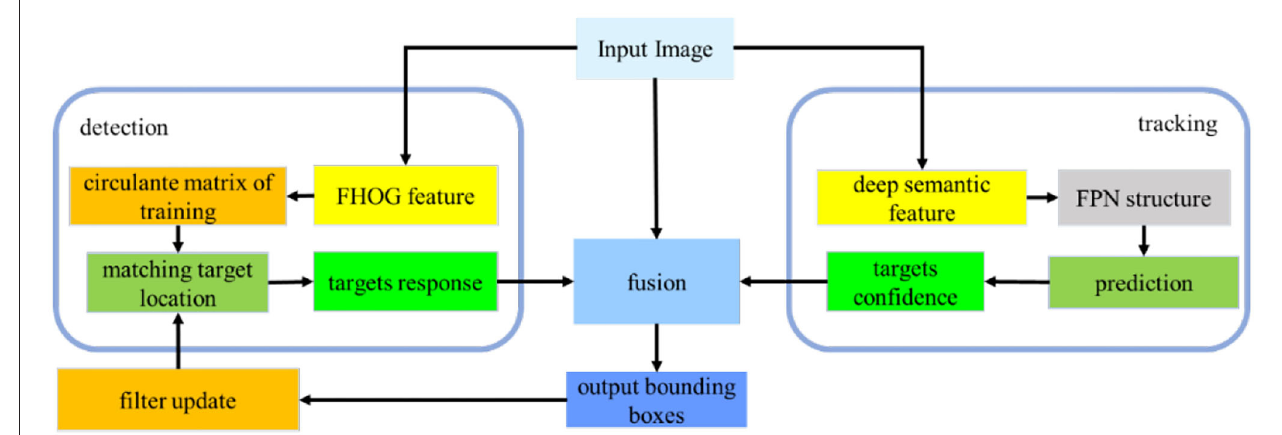
FIGURE 1 | An algorithm framework